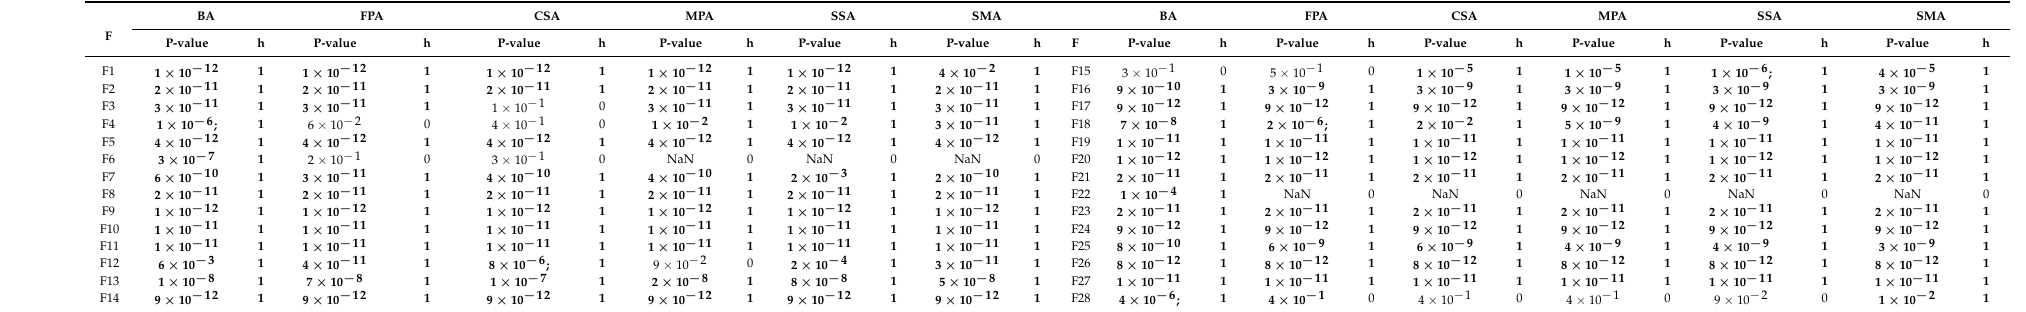
Table 3. Comparison under the Wilcoxon rank-sum test.